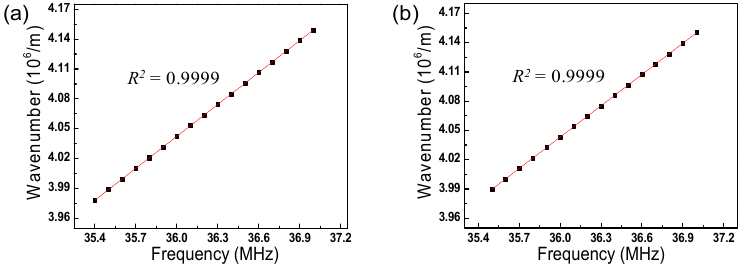
Figure 5. Linear relationship between applied RF signal and output wavenumber: ( a ) conventional WSL with AOTF; ( b ) proposed WCSL with AOTF.